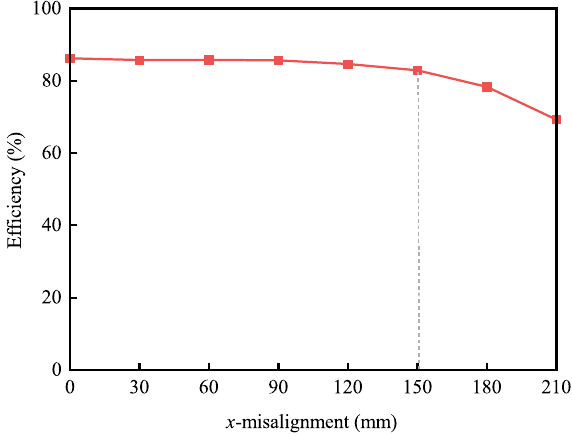
Figure 13. The measured DC-DC efficiency versus x -misalignment.